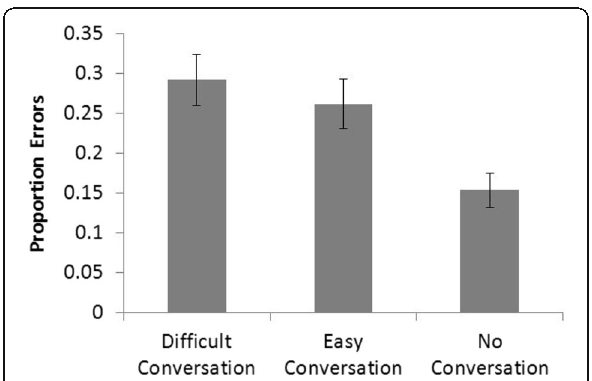
Fig. 3 The proportion of errors for each condition in experiment 1. Error bars represent the standard error